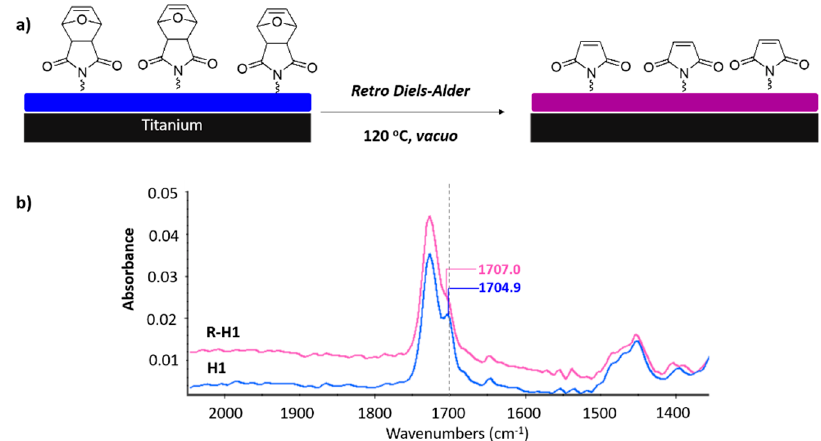
Figure 2. ( a ) Removal of furan groups via retro Diels–Alder reaction. ( b ) ATR-FTIR spectra of H1 before and after thermal treatment via retro Diels–Alder hydrogel H1 before and after thermal treatment via retro Diels–Alder reaction.